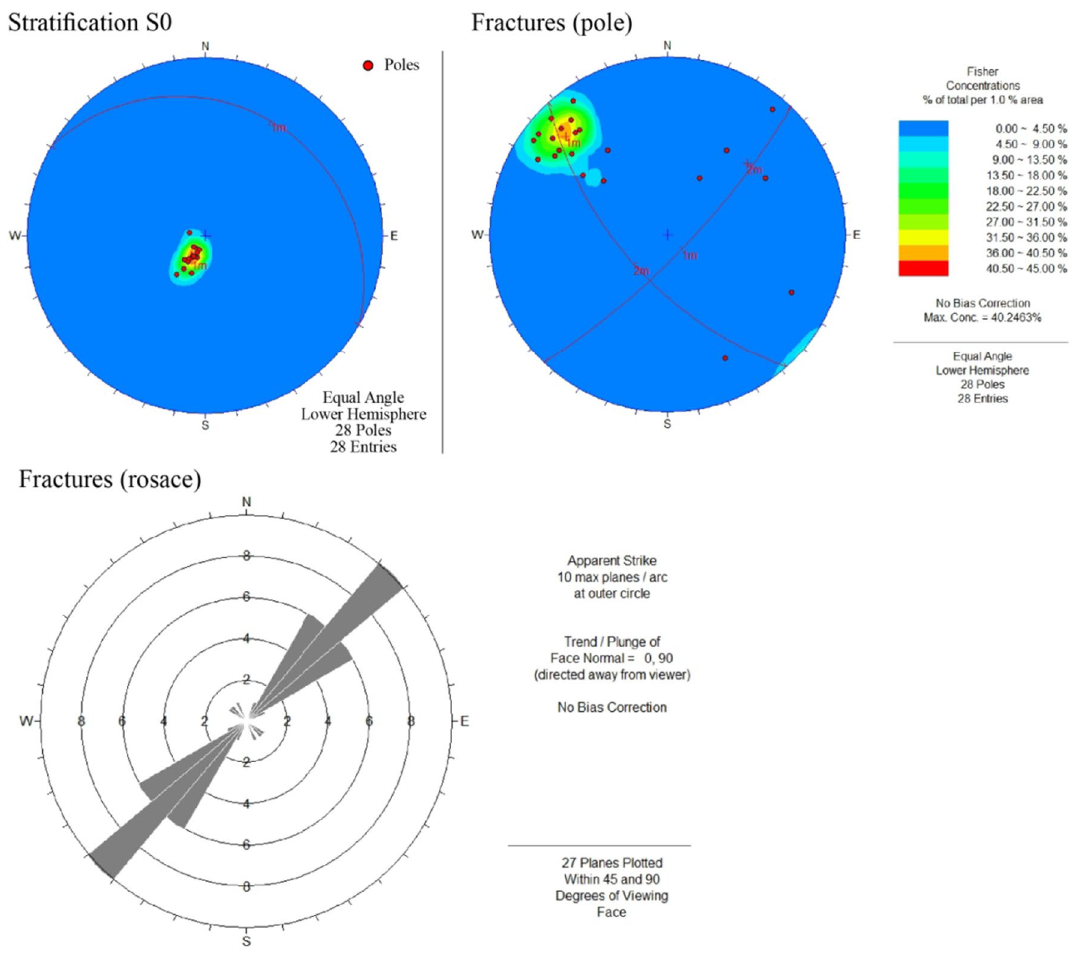
Fig. 10 Stereographic projections of families of faults in the causse of